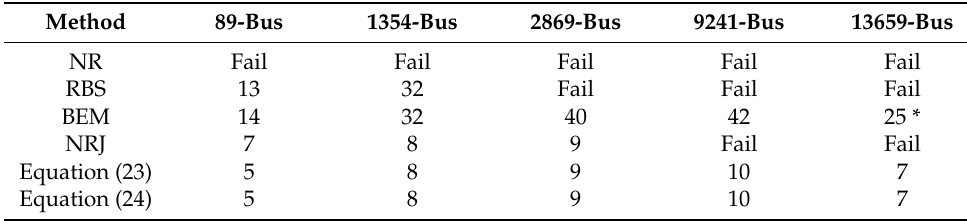
Table 4. Total iterations with reactive limits.